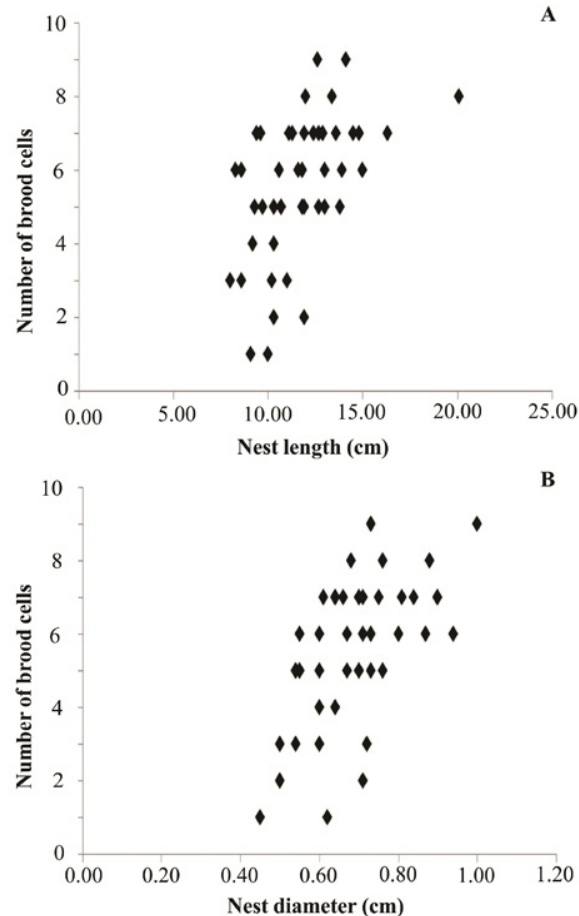
Fig 3. Number of brood cells produced in Tetrapedia curvitarsis nests, according to length (A) and diameter (B) of